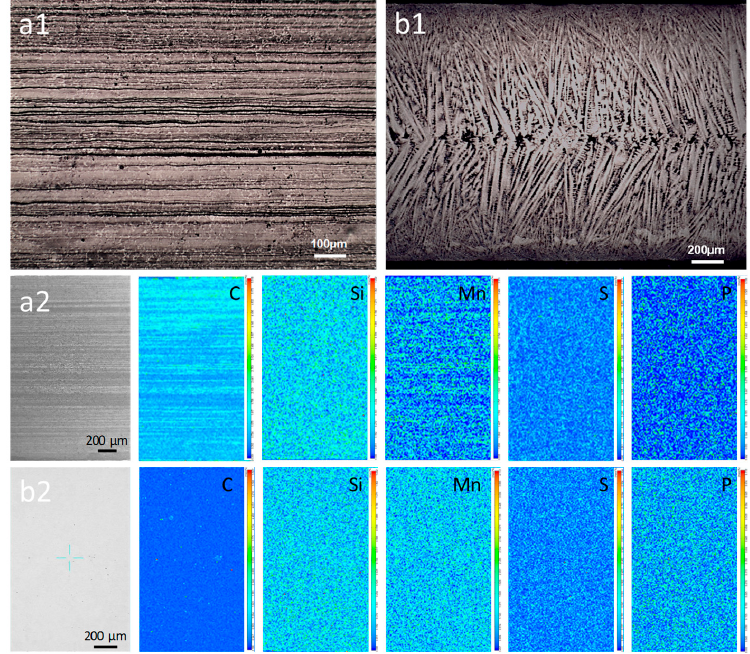
Figure 2. Microstructural analysis and alloying elements mapping of the hot-rolled strips by OM and EPMA. ( a1 , a2 ) CSP-50#. ( b1 , b2 ) TRC-50#-10. The optical micrographs of CSP-50#, TRC-50#-10 and TRC-50#-33 and their typical C concentration profiles from the surface to the interior are shown in Figure 3. The ferrite fraction of the CSP-50# gradually decreases from the surface to the interior, indicating that there is a partial decarburization layer on the sample surface, as shown in Figure 3a. The typical C concentration profile shown in Figure 3b reveals that for the CSP-50#, the con- centration of C increases gradually from the surface to the interior. The average surface decarburization layer thickness of the CSP-50# is 13.3 μ m. In contrast, the optical micro- graphs in Figure 3c,e show that the ferrite fraction of TRC-50#-10 and TRC-50#-33 almost remain unchanged from the surface to the interior. The EPMA results in Figure 3d,e show that the C concentration of TRC-50#-10 and TRC-50#-33 remains unchanged with an in- crease in distance from the surface to the interior. Thus, it indicates that there is no obvious decarburization on the surface of TRC-50#-10 and TRC-50#-33.